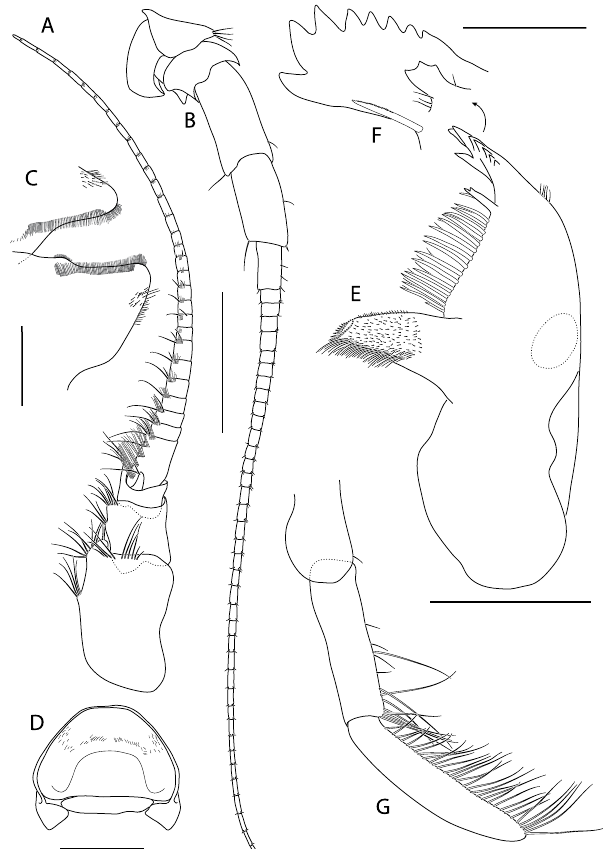
Figure 9. Epimeria frankei sp. nov., holotype, adult female, northern North Sea, NHMUK 2015.3264: ( A ) antenna 1, ( B ) antenna 2, ( C ) hypopharynx, ( D ) mandible, ( E ) mandible incisor and lacina mobilis, ( F ) mandibular palpus, ( G ) labrum; scales: (A,B) 1 mm; (C,D,E,G) 0.5 mm; (F) 0.25